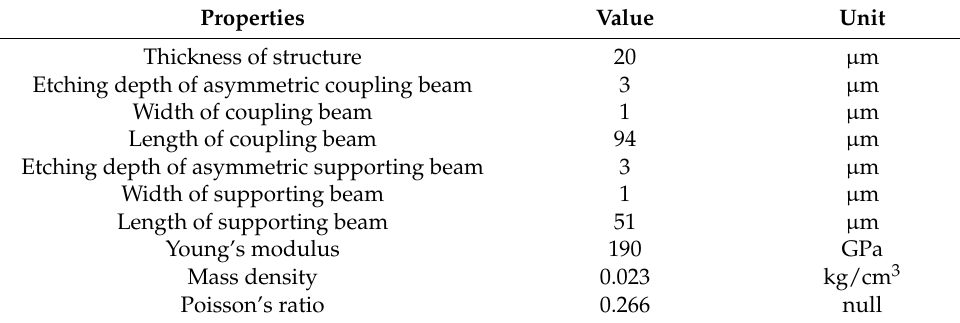
Table 1. Important structure parameters in the simulation.